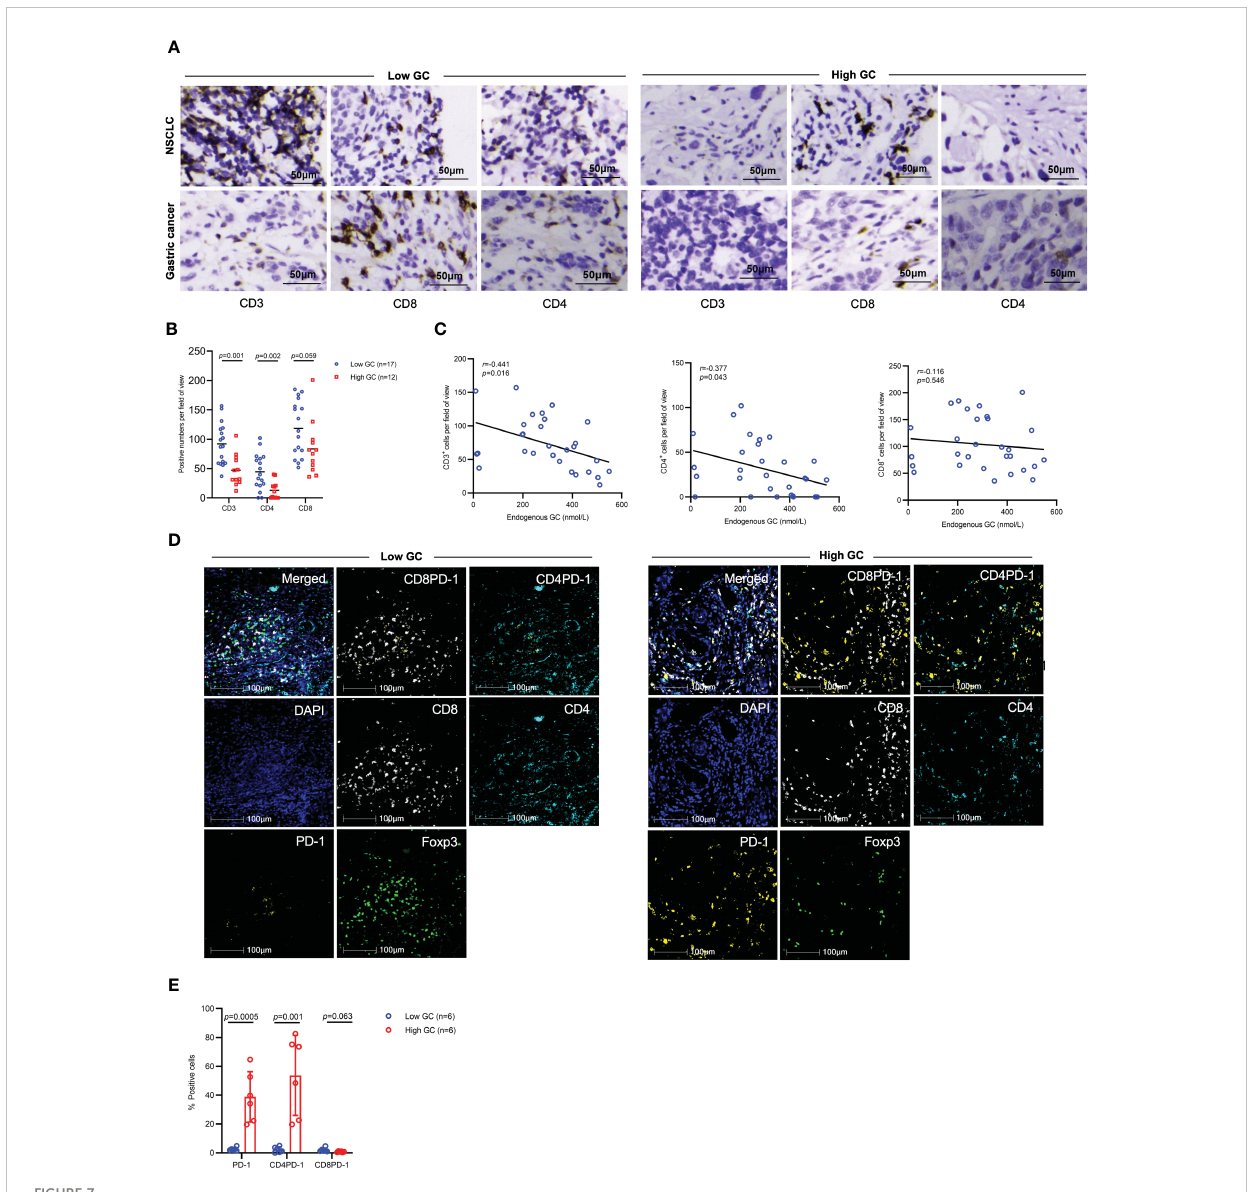
FIGURE 7 The effect of endogenous GC on immune cell in fi ltration. (A) Representative IHC images for tumor in fi ltrating CD3 + , CD8 + , and CD4 + cells in advanced gastric cancer or NSCLC patients with high or low baseline endogenous GC levels. (B, C) Comparing the numbers of tumor in fi ltrating CD3 + , CD8 + , and CD4 + cells per fi eld of view in advanced cancer patients with high (n=12) or low (n=17) endogenous GC levels. (D, E) The mIF analysis of immune cell in fi ltration in NSCLC tumors with high (n=6) or low (n=6) baseline endogenous GC